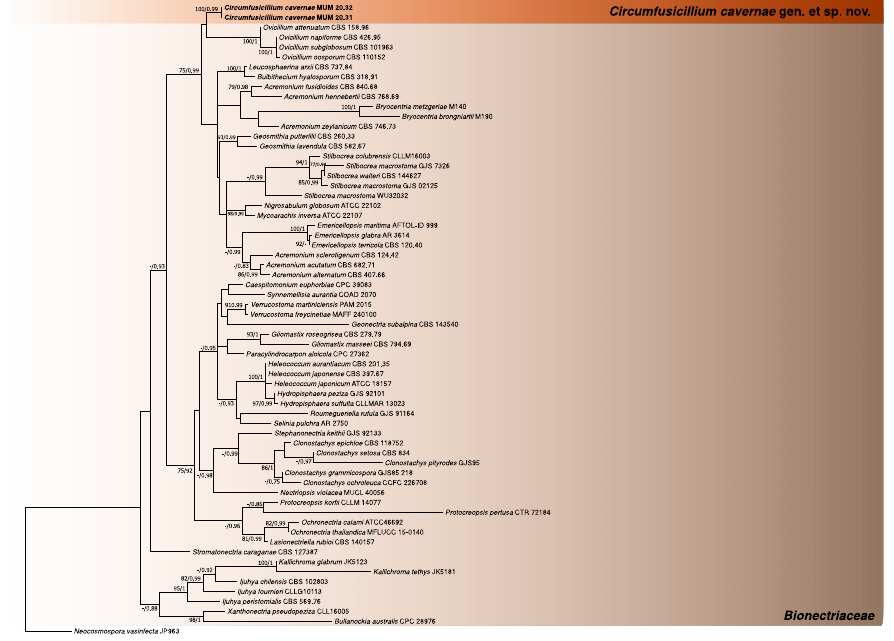
Figure 1. Phylogenetic trees obtained using reference Bionectriaceae LSU sequences. The new taxa are indicated in black and bold . The scale bar indicates the number of substitutions per site, and the support values (>75% bootstrap values for Maximum likelihood and >0.75 for Bayesian MCMC posterior probabilities) are also shown. J. Fungi 2022 , 8 , x FOR PEER REVIEW